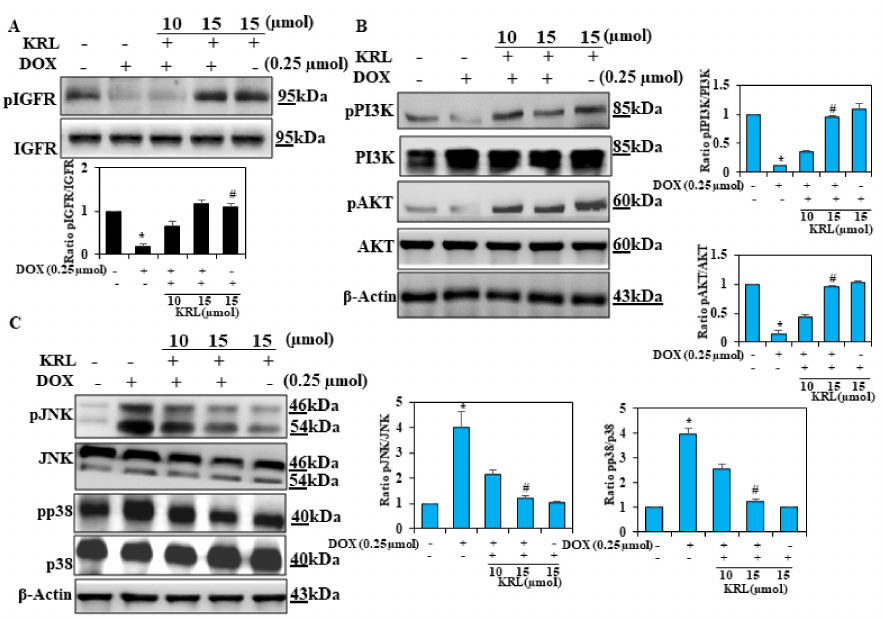
Figure 3. KRL enhances cell survival mechanism. H9c2 cells were cultured in serum-free media for 3 h, followed by treatment with KRL for 2 h before or after DOX treatment, respectively. ( A , B ) KRL activates the IGF1R-mediated survival pathway in H9c2 cells. The expression of p-IGF1R, PI3K, p-PI3K, AKT, and p-AKT was analyzed by Western blotting. β -actin was used as the internal control. ( C ) Representative Western blots showing the changes in MAPK signaling proteins (pP38 and pJNK) in H9c2 cells. Data are represented as the mean ± SD of triplicate values ( n = 3) and * p < 0.05 represents significant variations compared with the control. # p < 0.05 represents significant variations as compared to DOX alone and KRL with DOX treatment